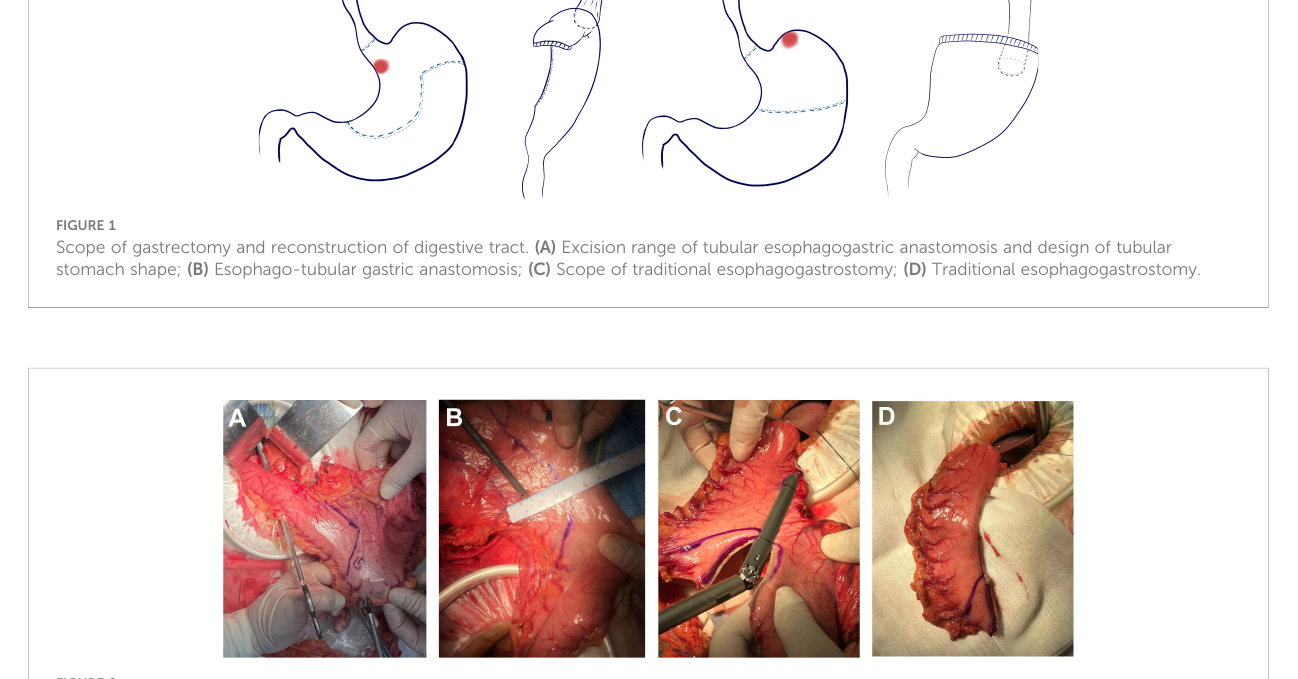
FIGURE 2 The procedural steps of tubular stomach operation. (A) Designing a tubular stomach shape. Lines were drawn from the pylorus 5cm above the pylorus along the minor curvature of the stomach to the side of the mouth, The residual stomach was designed to form a tubular structure